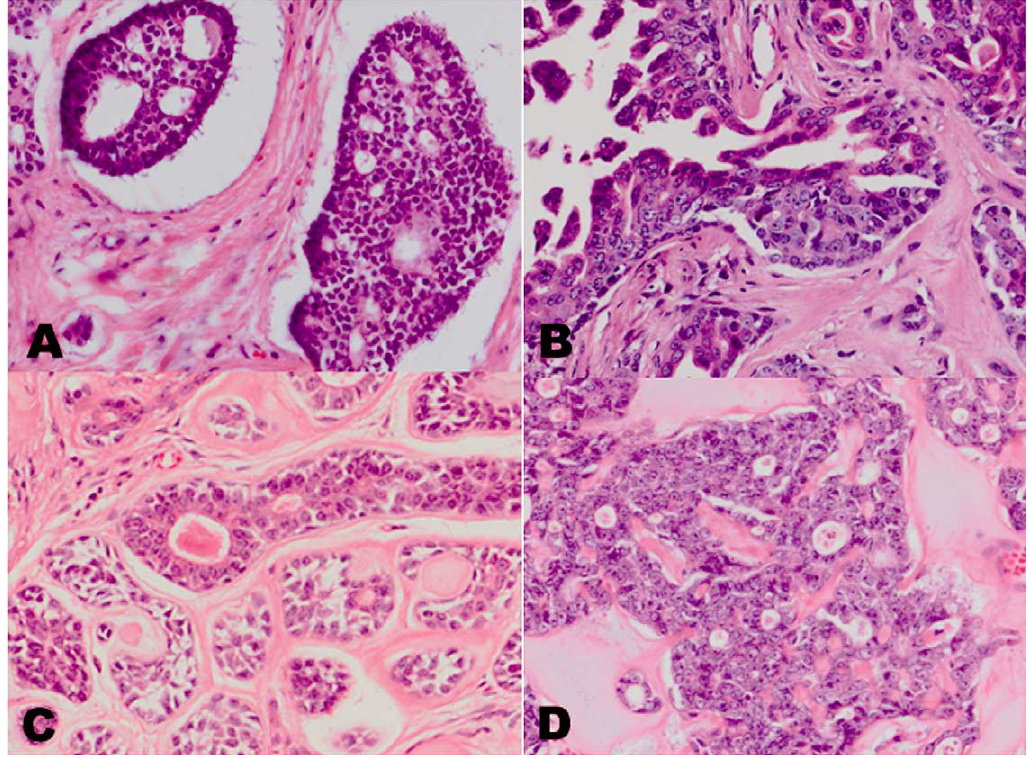
Fig. 1. ACC-HGT to a moderately differentiated adenocarcinoma, case C (A, B). ACC-HGT to poorly differentiated carcinoma, case F (C, D). H&E original magnification 200 × (A, B, C and D). (Colors are visible in the online version of the article; http://dx.doi.org/10.3233/ACP-CLO-